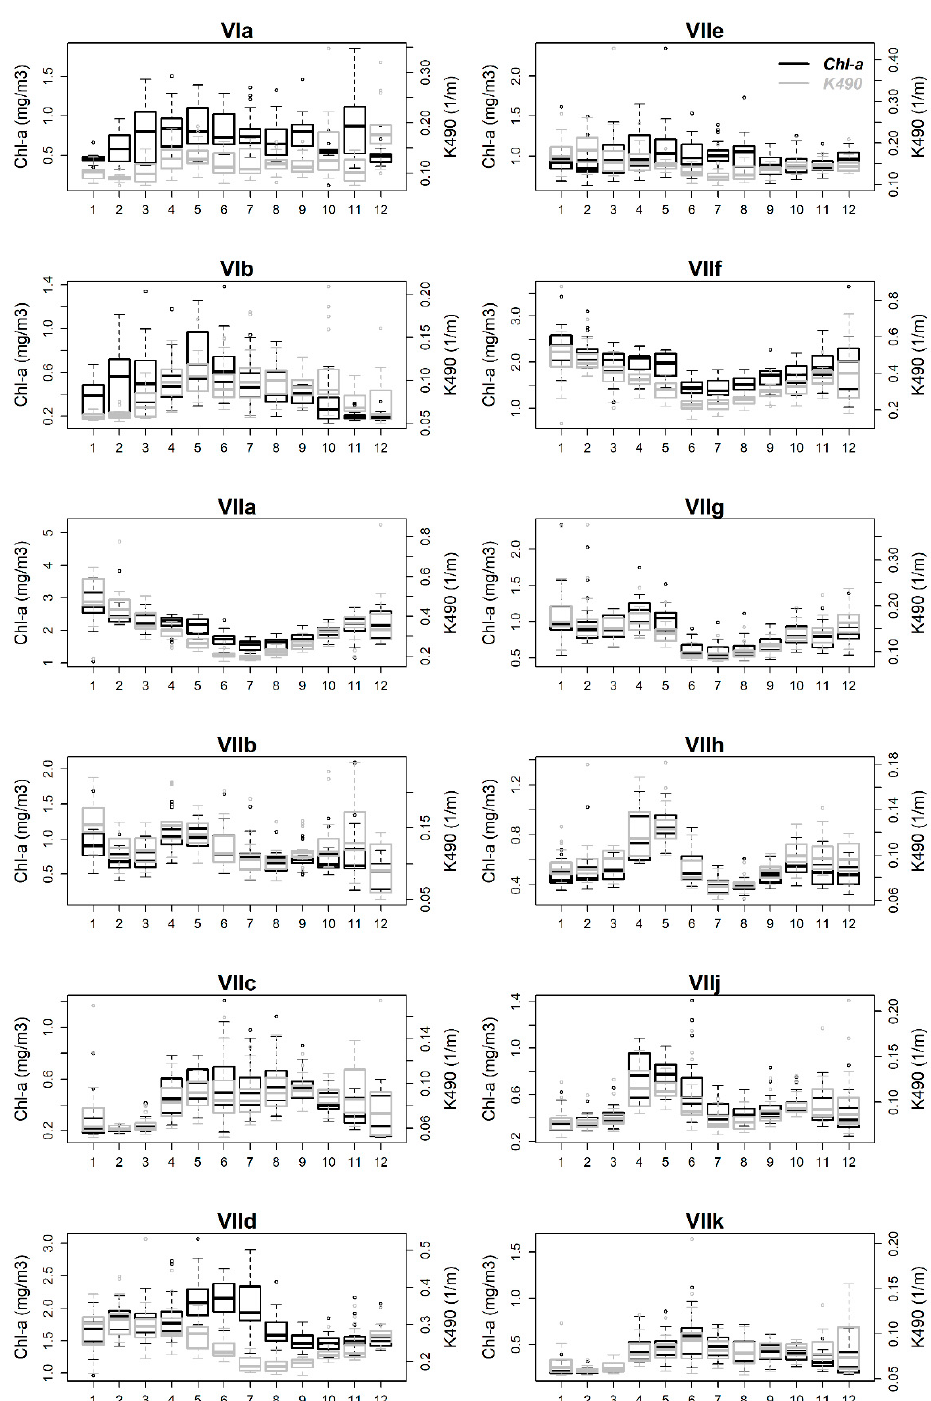
Figure 4. Seasonal variation for Chl-a (mg/m 3 ) and K490 (1/m) considering the nineteen-year time series. Note that the y-axis scale is not the same to better illustrate monthly variability and temporal differences between ICES divisions. The size of the boxes indicates the interquartile range (IQR), and the horizontal line inside represents the median. The vertical lines indicate the variability outside the upper and lower quartiles, while the individual points beyond the vertical lines represent the outliers.